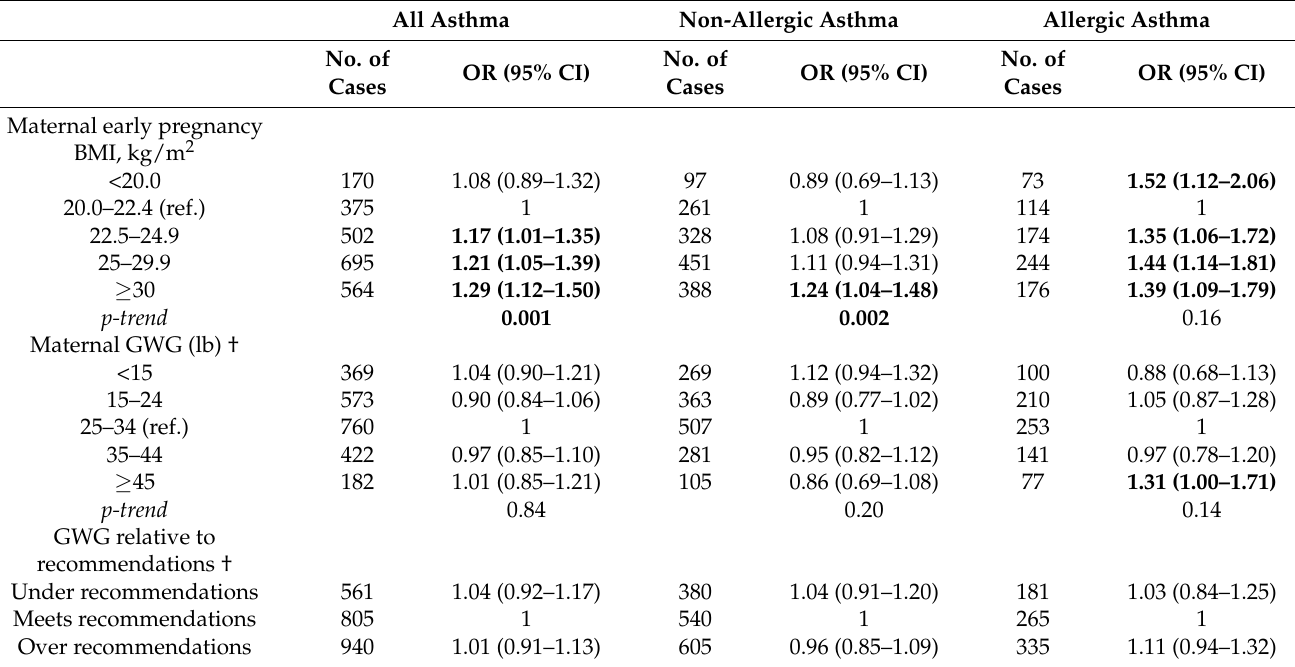
Table 3. Associations of GDM with incidence of allergic and non-allergic asthma in childhood.